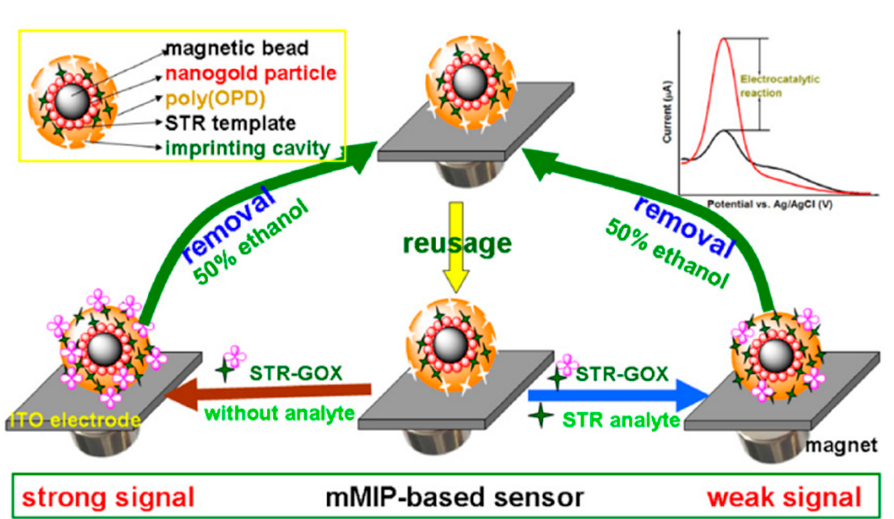
Figure 4. Schematic illustration of nanogold-promoted magnetic molecularly imprinted polymer nanospheres for competitive-type electrochemical detection of streptomycin (STR) residues by coupling with bioelectrocatalytic reaction of glucose oxidase (GOX) for signal amplification [149] (Reproduced with permission from Elsevier Ltd.).